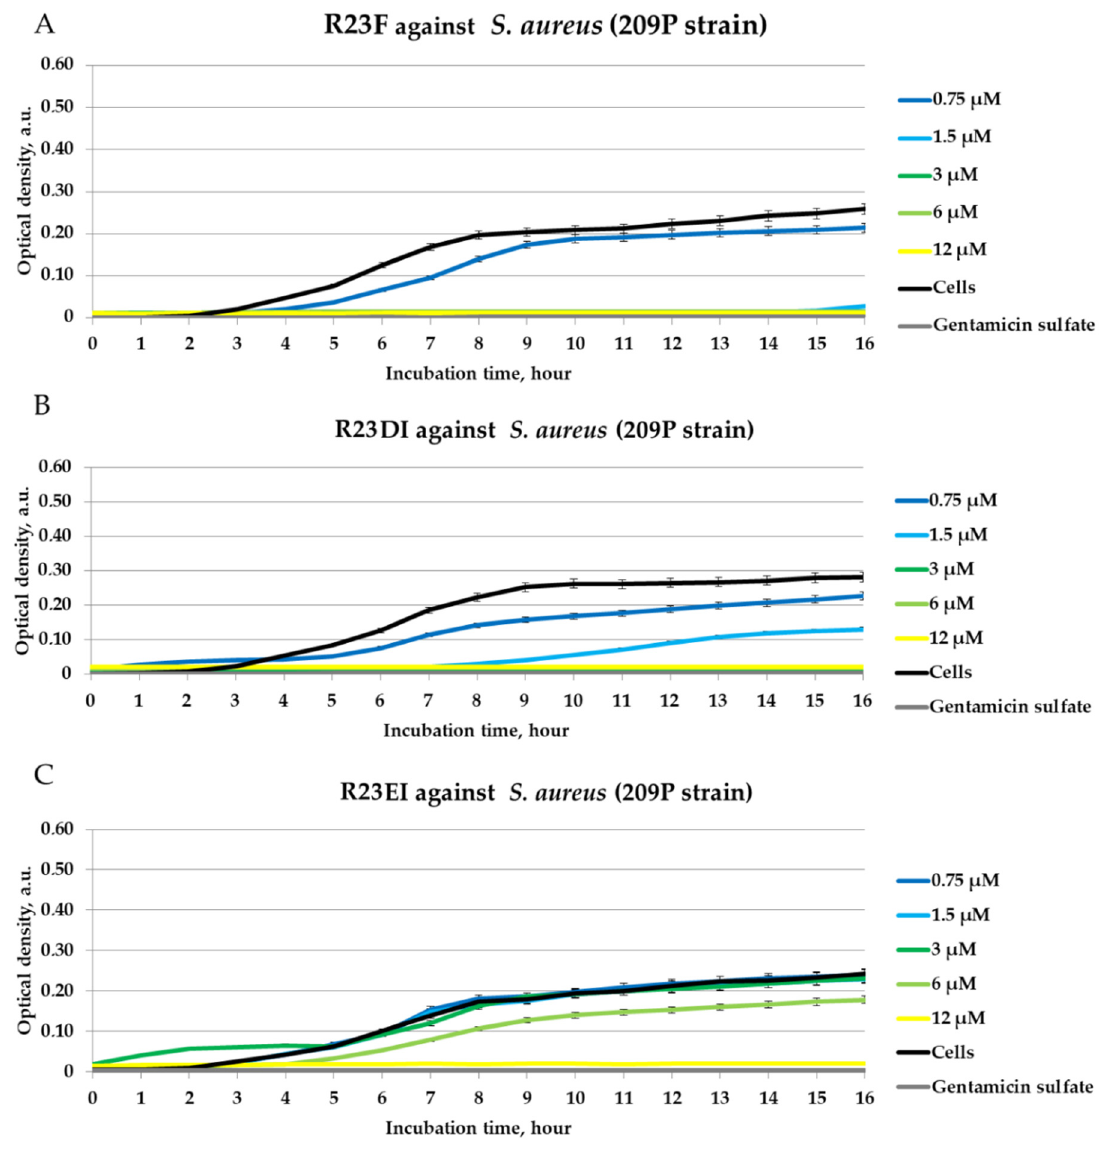
Figure 6. Inhibitory activity of peptides R23F ( A ), R23DI ( B ), R23EI ( C ) during 16 h of incubation with S. aureus strain 209P cells. A gentamicin sulfate concentration of 1700 µ M was used as a positive control of the antimicrobial effect. 209P cells without peptide were used as negative controls. The experiments were performed in three replicates. The results were expressed as the mean ± standard deviation (M ± SD).